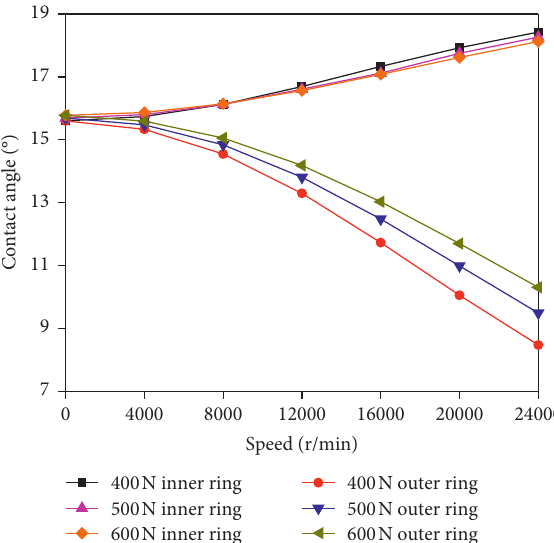
Figure 10: Influences of the speed and preload on contact angle.